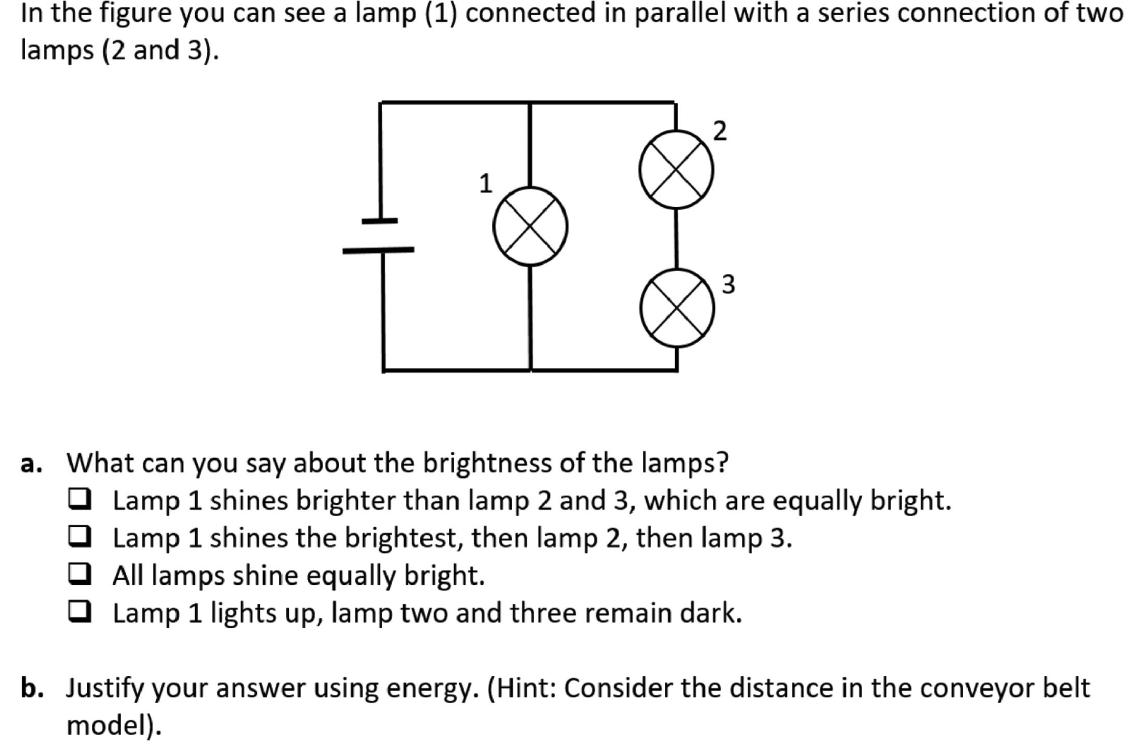
FIG. 4. Example of an item in the electric energy